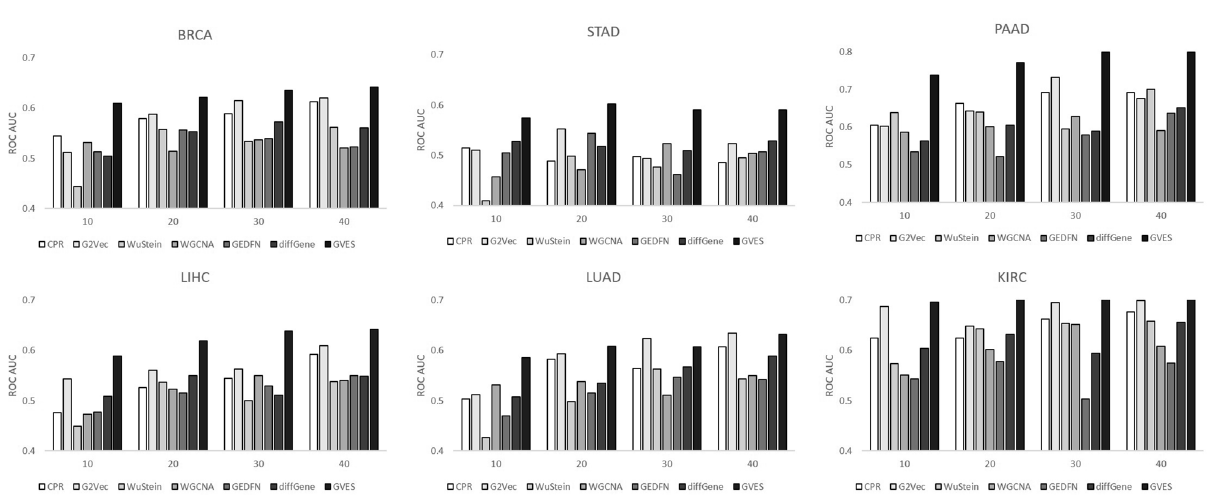
Figure 4. AUC measured for each cancer type varying sample size. Y-axis indicates mean AUC of fivefold cross validations for each cancer type varying number of samples used for